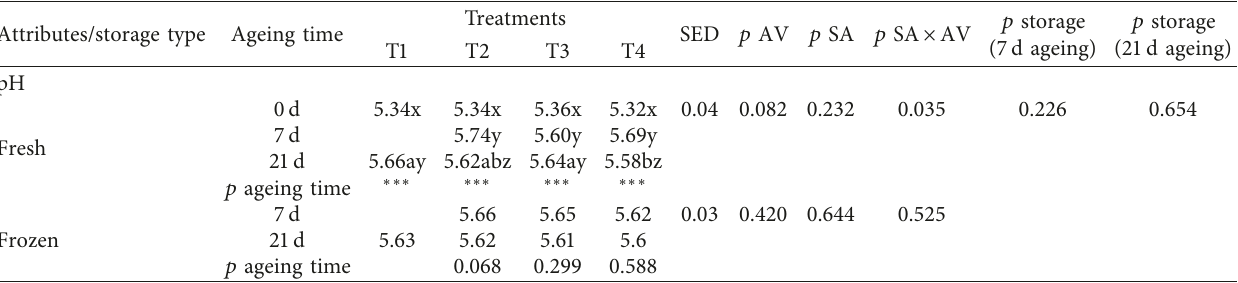
Table 2: Effect of ageing treatments, ageing time, and frozen storage on pH of in-bag dry-aged lean bull beef. Attributes/storage type